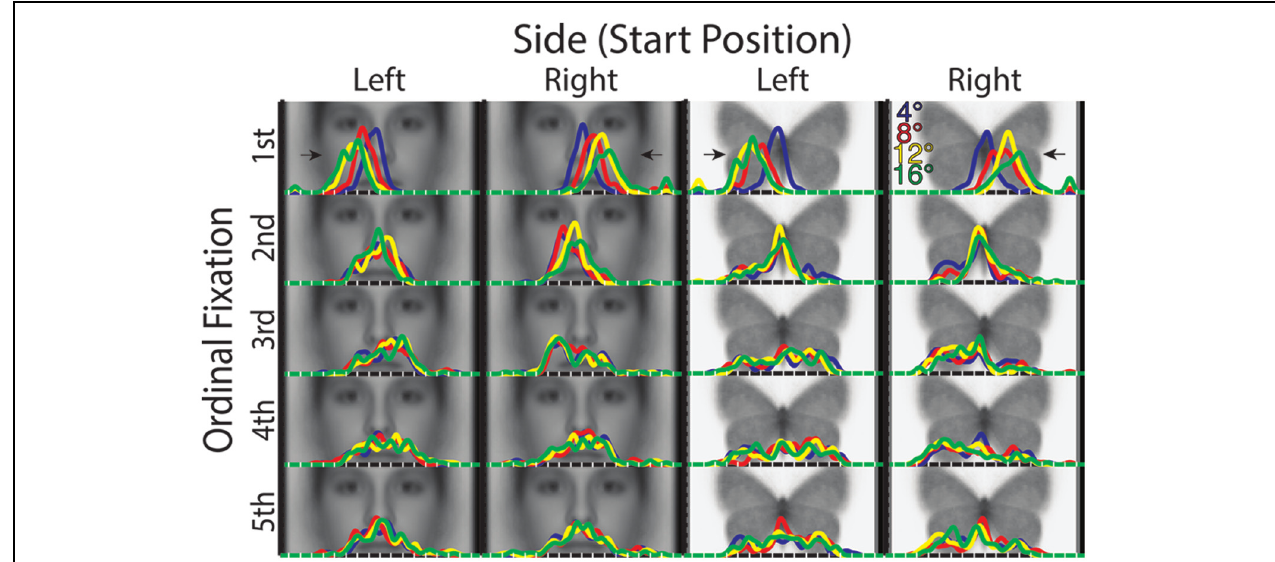
FIGURE 4 | X -dimension profile density plots by stimulus category, starting distance, starting side, and ordinal fixation. Of note is the increasing distance of fixations from midline of the stimulus in the first ordinal fixation with increasing starting distance. Also, there is